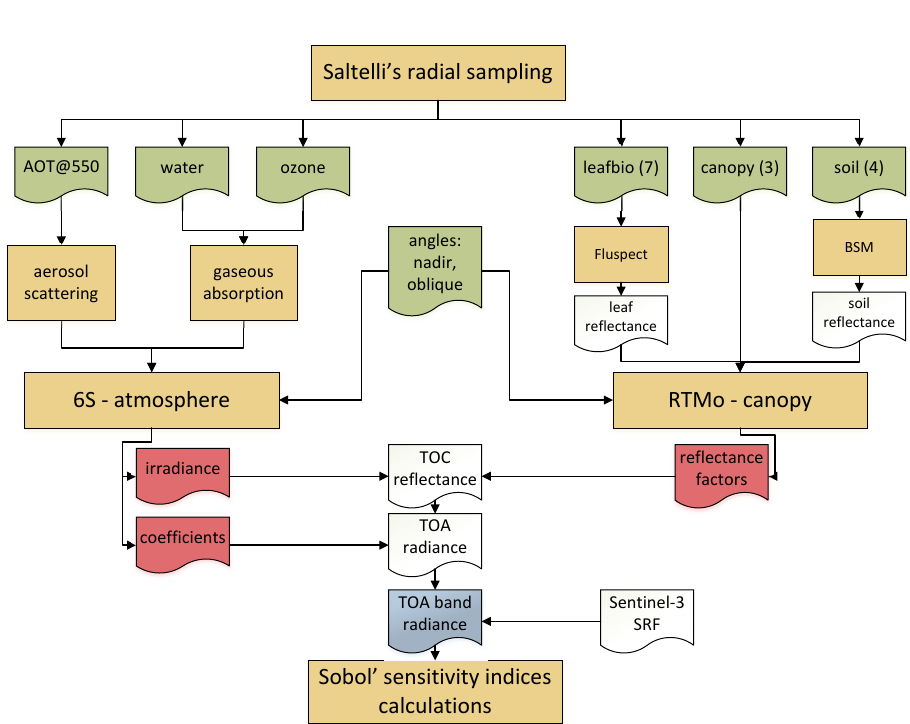
Figure 2. Workflow: sampling, model runs, sensitivity indices calculation. Varied input parameters are highlighted in green: atmospheric input consists of 3 parameters: AOT@550, water and ozone; leafbio consists of 7 leaf optical parameters: Cab, Cca, Cdm, Cs, Cw, Cant, N; canopy consists of 3 parameters: LAI, LIDFa, LIDFb; soil consists of 4 BSM model parameters: BSMBrightness, BSMlat, BSMlon and SMC. Notice, that angles (solar and viewing zenith and azimuth angles) were fixed to nadir or oblique configuration. Direct model outputs are highlighted in red. The output used for sensitivity index calculations is highlighted in blue. TOC—Top Of Canopy, TOA—Top Of Atmosphere. Definitions and ranges of input parameters can be found in Table